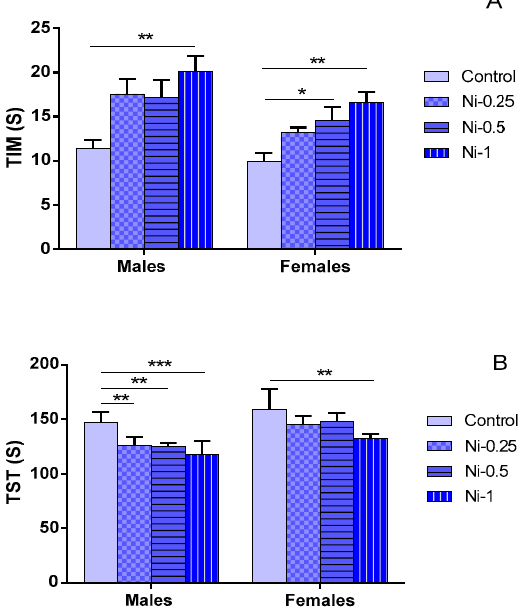
Figure 3. ( A ) Immobility time expressed in seconds (s) (TIM); ( B ) Struggling time (STS) in Forced swimming test expressed in seconds (s) in female and male rats after 2 months of treatment with 0.9% of NaCl (Control), 0.25 mg/kg (Ni-0.25), 0.5 mg/kg (Ni-0.5), and 1 mg/Kg (Ni-1) of Ni. Results are represented as mean ± SEM. The significance level is 0.05. * p < 0.05, ** p < 0.01, *** p < 0.001.